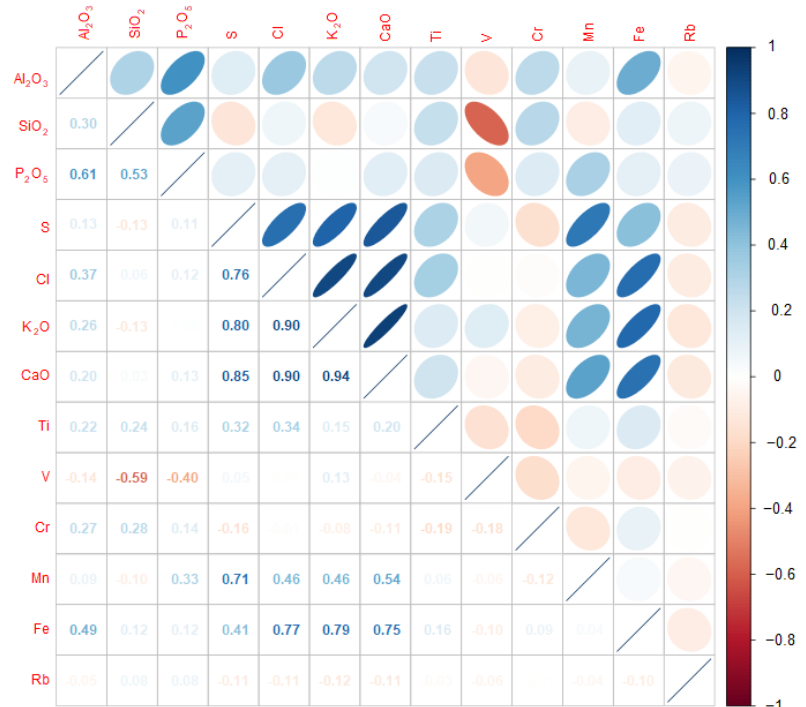
Figure 3. Correlation coefficient between the elements and oxides obtained by portable X-ray fluorescence ( p XRF) spectrometry in different varieties of quartz.